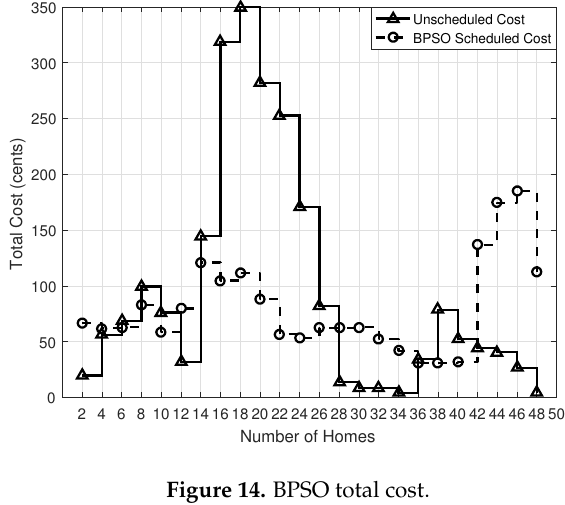
Figure 14. BPSO total cost.